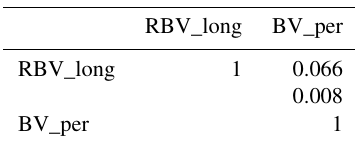
Table 8. Correlations between BV of persistency and RBV of